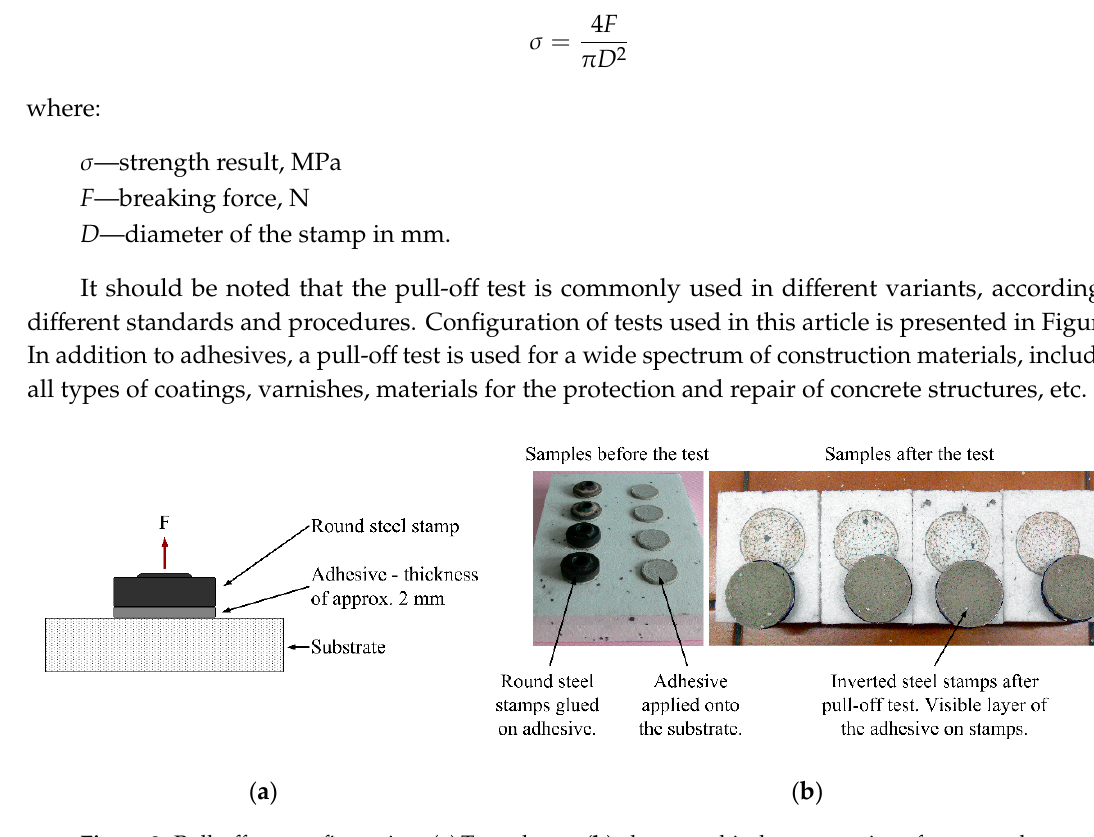
Figure 3. Pull-off test configuration. ( a ) Test scheme; ( b ) photographic documentation of an example Figure3. Pull-o ff testconfiguration. ( a )Testscheme; ( b test.